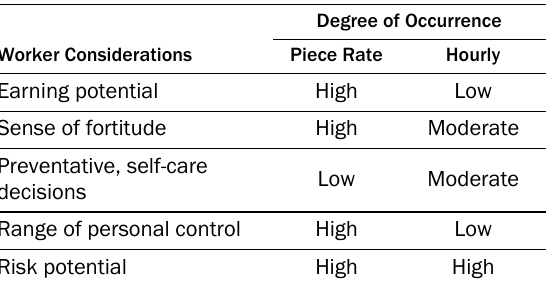
Table 8. Comparison of Worker